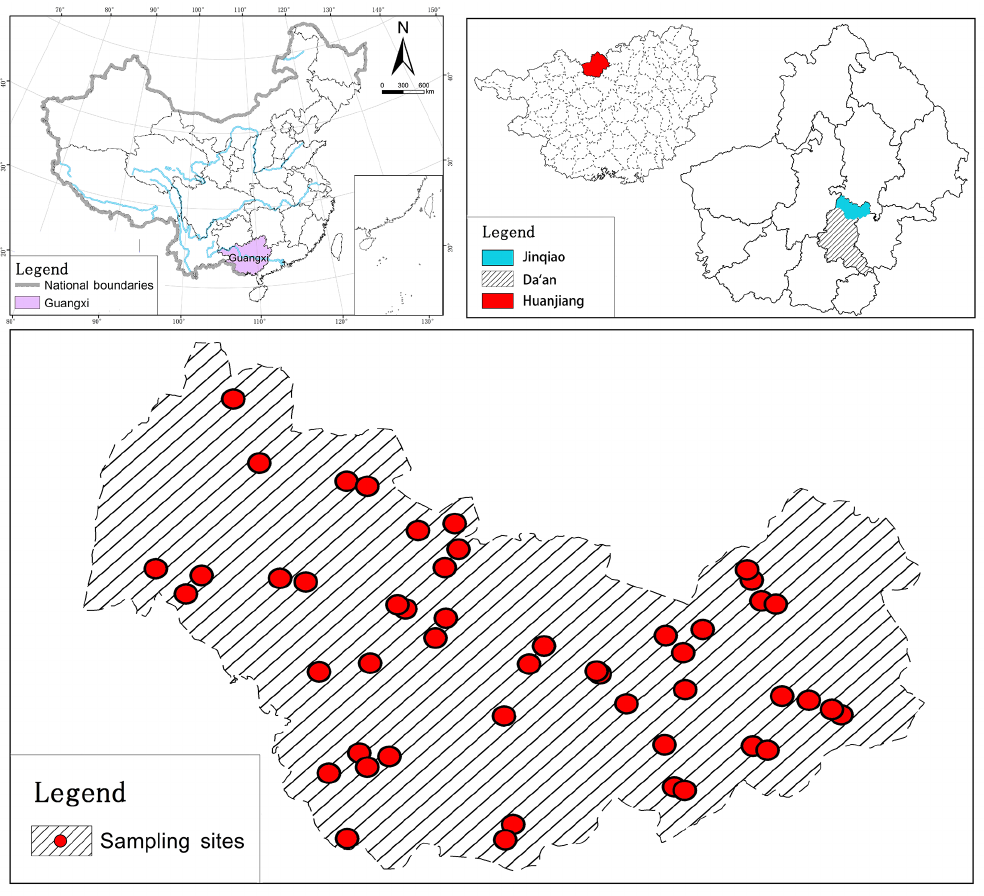
Figure 1. Location of the study area and the distribution of soil sampling sites in northwest Guangxi, southwestern China (Note: the sampling sites plotted in map do not represent the true numbers of sampling